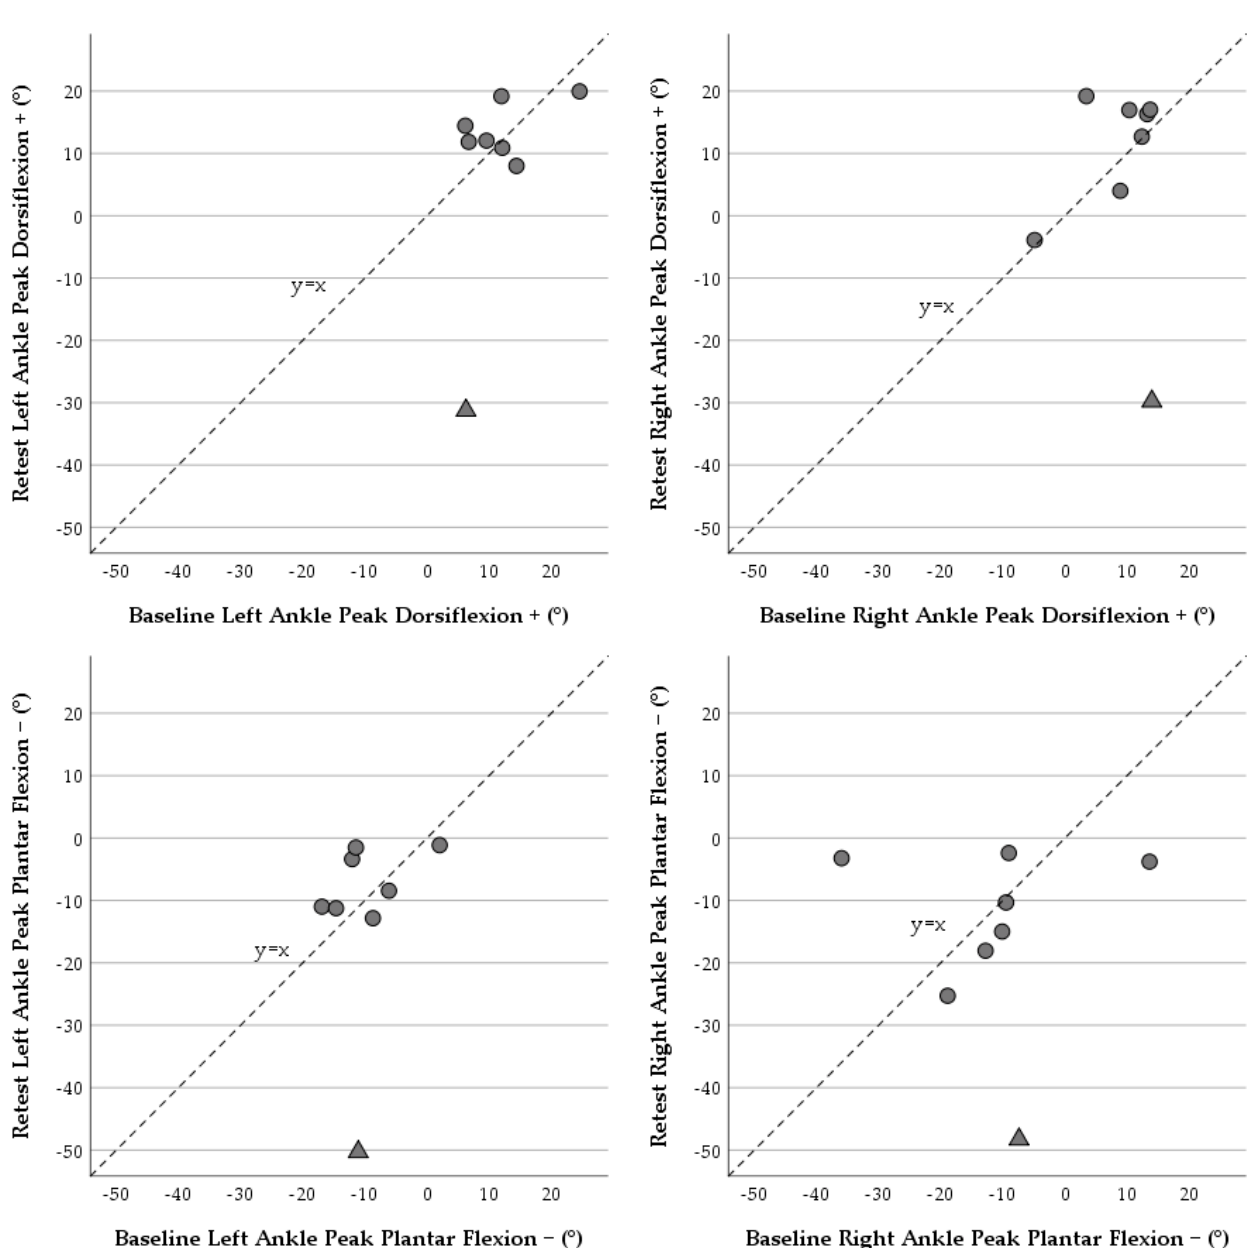
Figure 2. Scatter plots for ankle peak joint angles for dorsiflexion and plantar flexion. Subject with increased gastrocnemius stiffness values is represented with a different symbol from the rest.